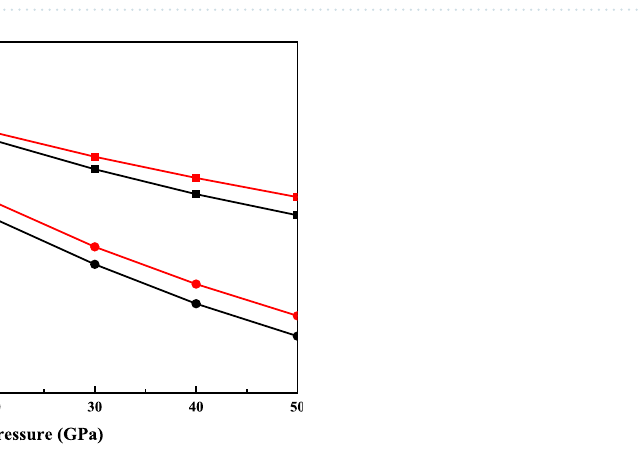
Figure 2. The pressure dependence of a / a 0 , c/ c 0 and volume V/V 0 for M 2 GaC (M = Zr, Hf) MAX phase at T = 273 K.